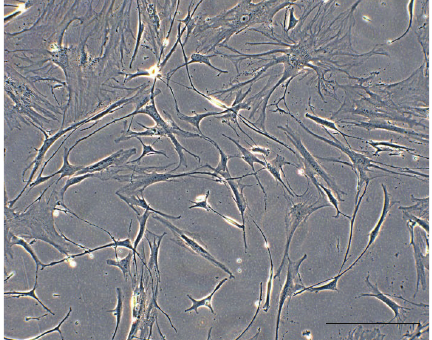
Figure 9: Cancer stem cell line OSA3-CSCs. Observation in phase contrast. Original magnification: 10x. Bar size: 100 𝜇